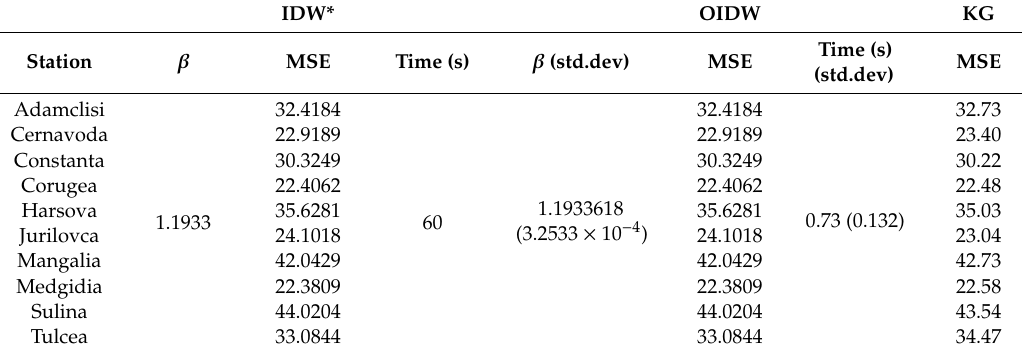
Table 1. The values of the β parameter obtained in experiments performed using the series recorded at the ten main meteorological stations, in scenario A1. For OIDW, the values in the parenthesis are the standard deviation of the parameter identified, computed over the 50 independent runs. Comparison with KG.